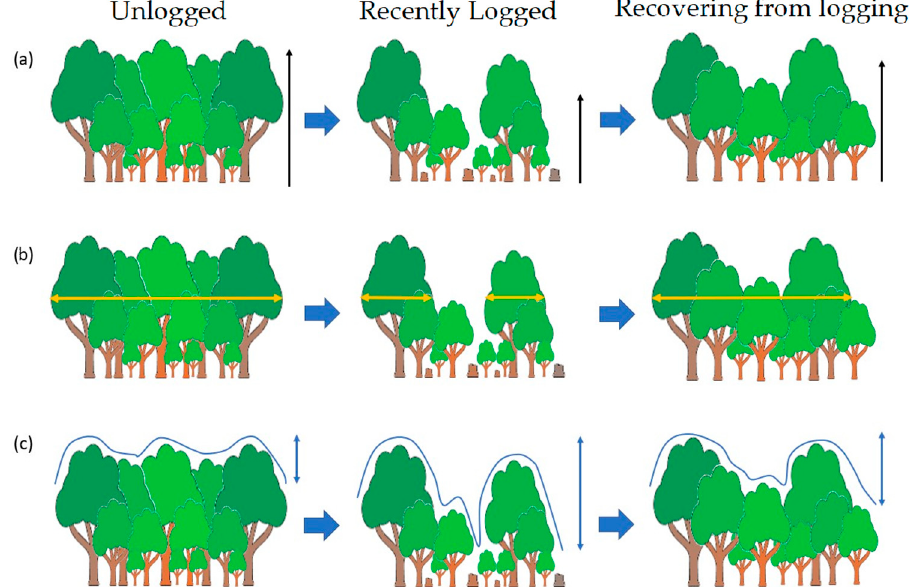
Figure 1. An illustration depicting the changes in each of the three ecosystem morphological traits over time in a forest stand which is subject to both selective logging and then a period of stand recovery. ( a ) Vegetation height—there is initially expected to be a decrease in the vegetation height EMT immediately after logging and this will then increase over time as the stand recovers and the trees continue to grow. ( b ) Vegetation cover—there is expected to be an initial reduction in the vegetation cover EMT immediately after logging due to gaps in the canopy. This then increases over time as the stand recovers and the canopy infills. ( c ) Structural complexity of vegetation—the measurable structural complexity is expected to increase after logging due to the heterogeneity of the stand increasing and the opening of the canopy to permit greater detection of the understory. This is expected to decrease as the canopy infills and the understory grows over time. Table 1. Ecosystem morphological traits, their associated metrics, and examples of their use.